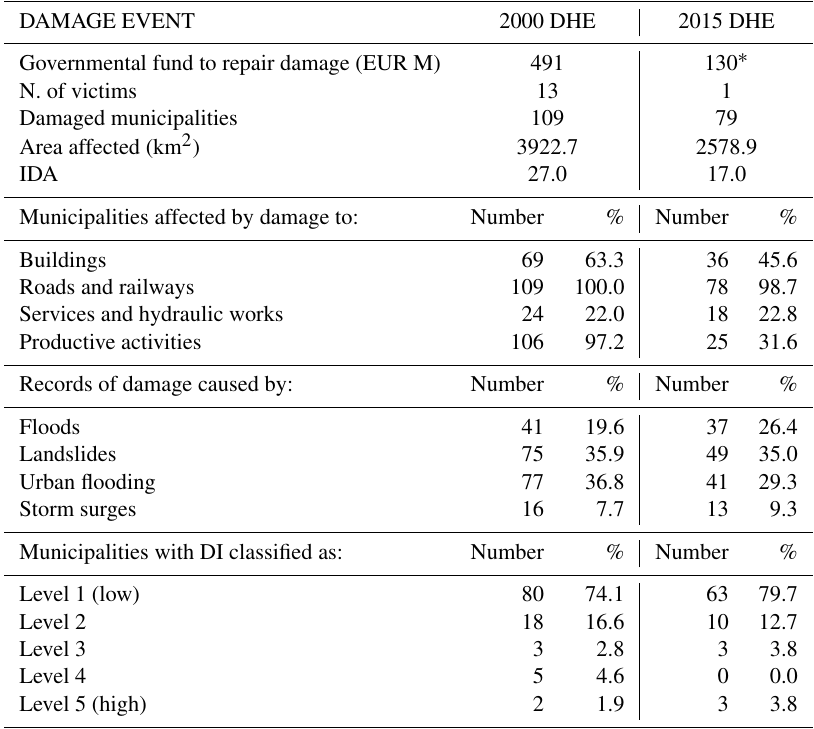
Table 2. Summary of the damage characteristics of the 2000 and 2015 DHE.